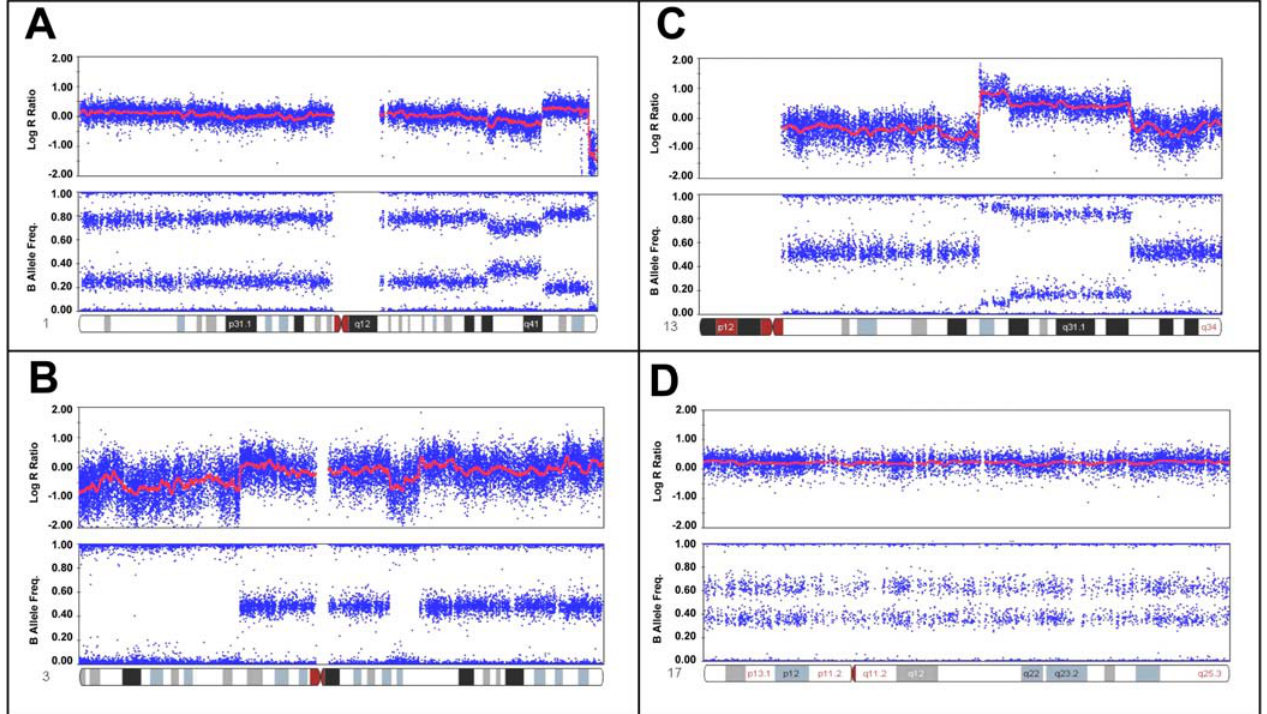
Figure 3. GW-SNP Assay Using the Illumina Infinium II Arrays Reveals Structural Variation in Chromosomes (A) Common laboratory cell line HEK293. (B) Common laboratory cell line M17. (C) Human embryonic stem cell line 293F7. (D) Human embryonic stem cell line Bg01P3SFF2. These include apparent multiplication and deletion mutations in the M17 and HEK293 lines, multiplication mutations across line 293F7, and duplication Chromosome 17 in line Bg01P3SFF2.